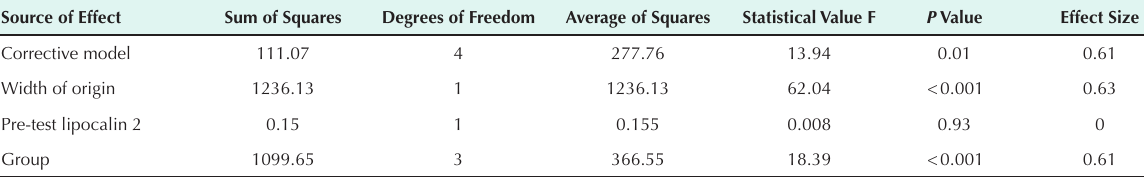
*Sign of significant difference in level P < 0.05 Table 3. Results of Analysis of Covariance Test for Evaluating the Effect of Exercise Interventions on Serum Lipocalin 2 Levels